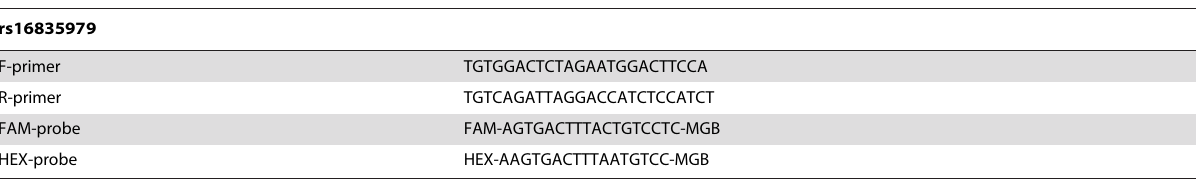
Table 1. Primers and probes of rs16835979.